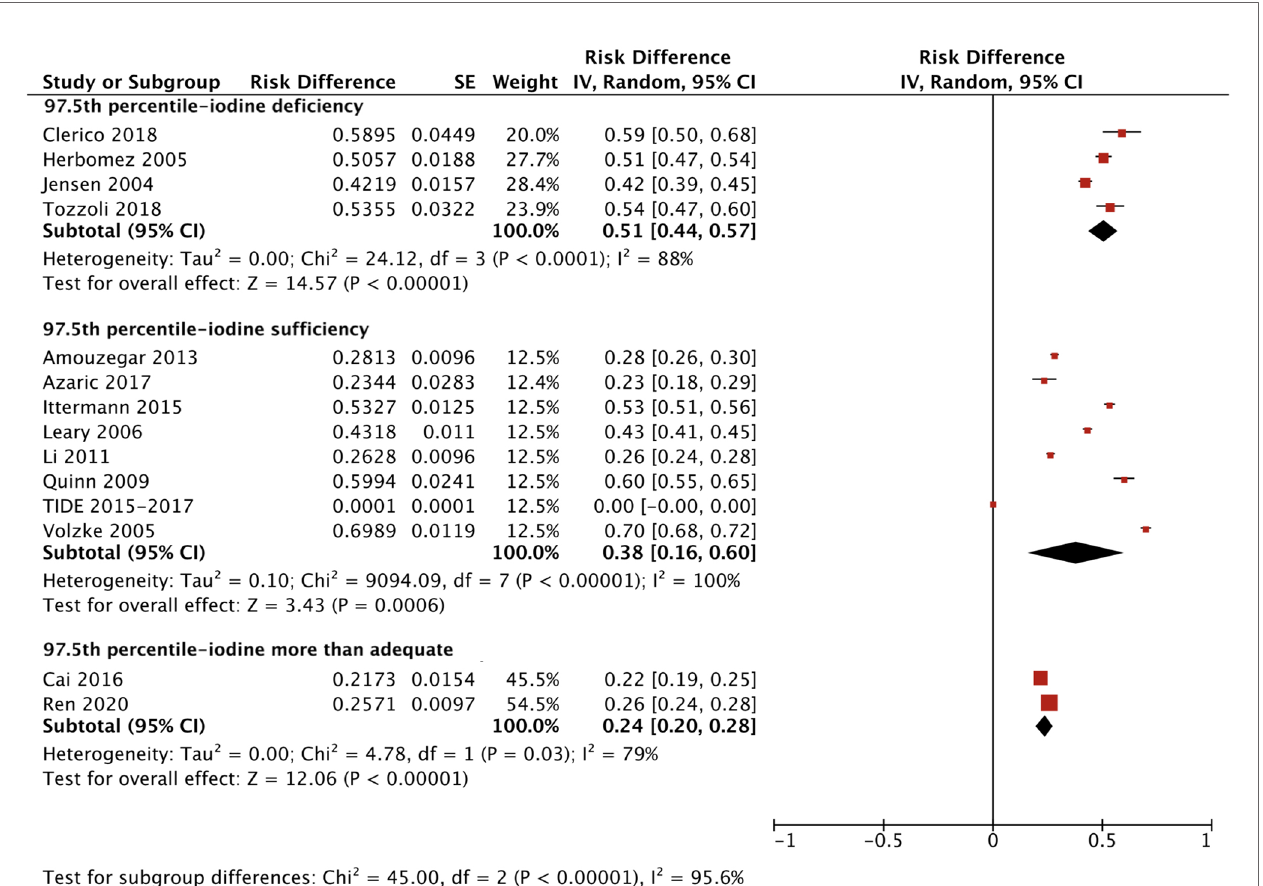
FIGURE 7 | Iodine status standardized forest plots of the pooled relative descent rate (%) of TSH upper limits (97.5 th percentile) in NACB